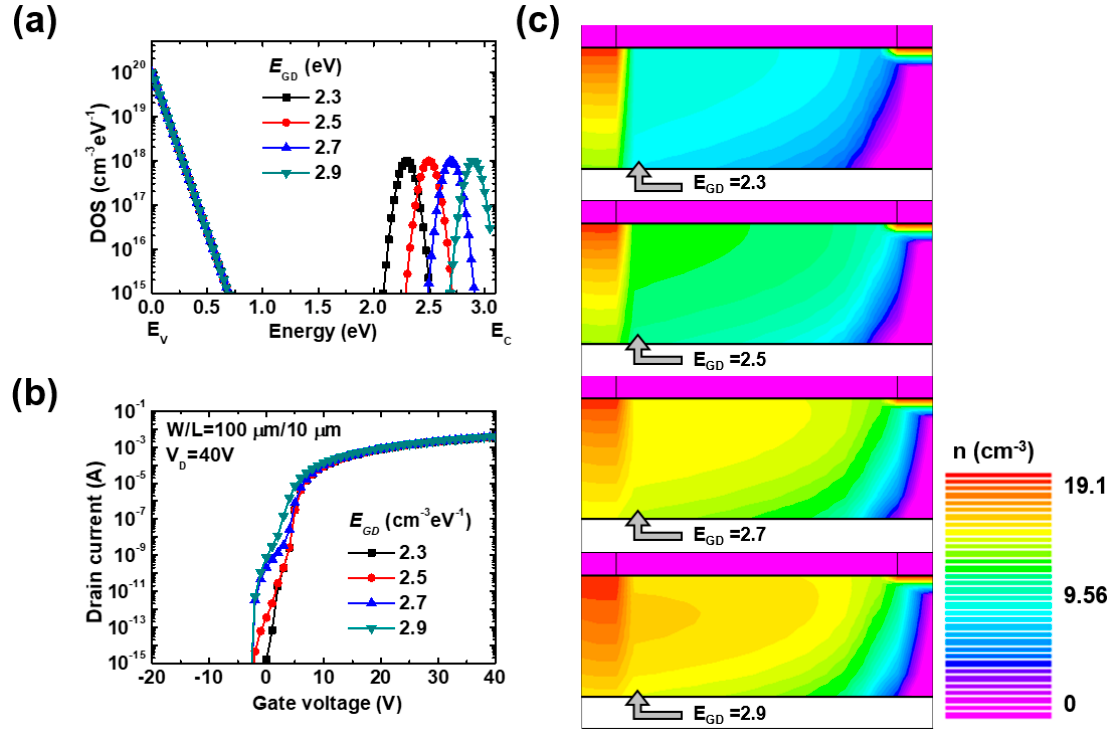
Figure 5. ( a ) DOS in sub-gap is shown as a function of energy. The E GD is controlled from 2.3–2.9. ( b ) Drain current according to applied gate voltage is shown at 40 V of drain voltage. ( c ) Each layer depicts the electron concentration distribution from top to bottom of N GD ranging from 2.3–2.9 eV at the saturation region 40 V of gate voltage and 40 V of drain voltage. The color table displays the electron concentration variations of 0–10 19.1 in varying colors.